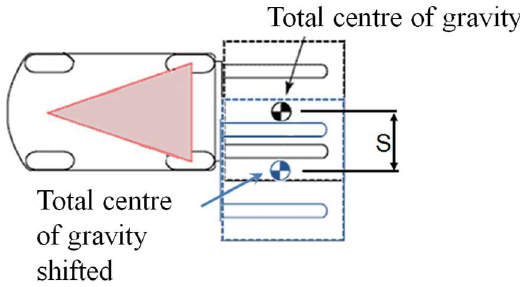
Figure 5. Lateral displacement.